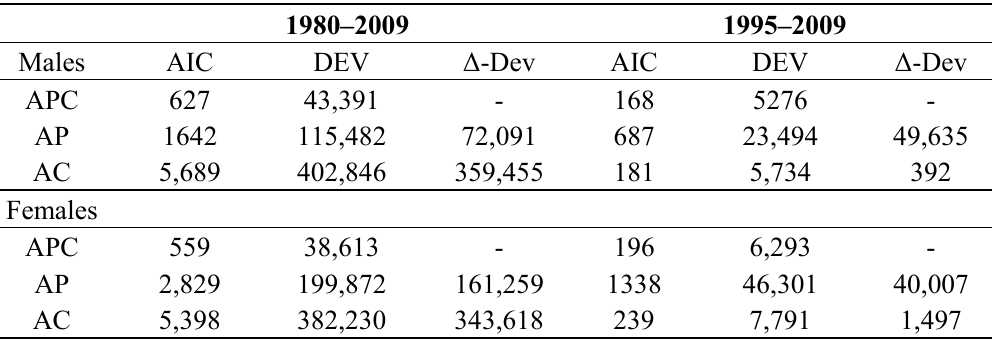
Table 1. APC model assessment for prevalence of former smokers in Italy in periods 1980–2009, and 1995–2009 for males and